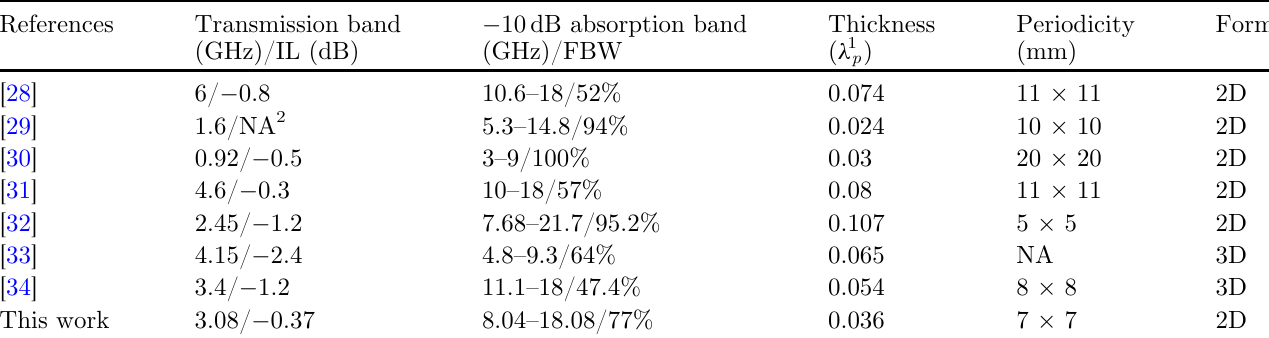
Table 2. Performance comparisons between the designed FSR and some FSRs in